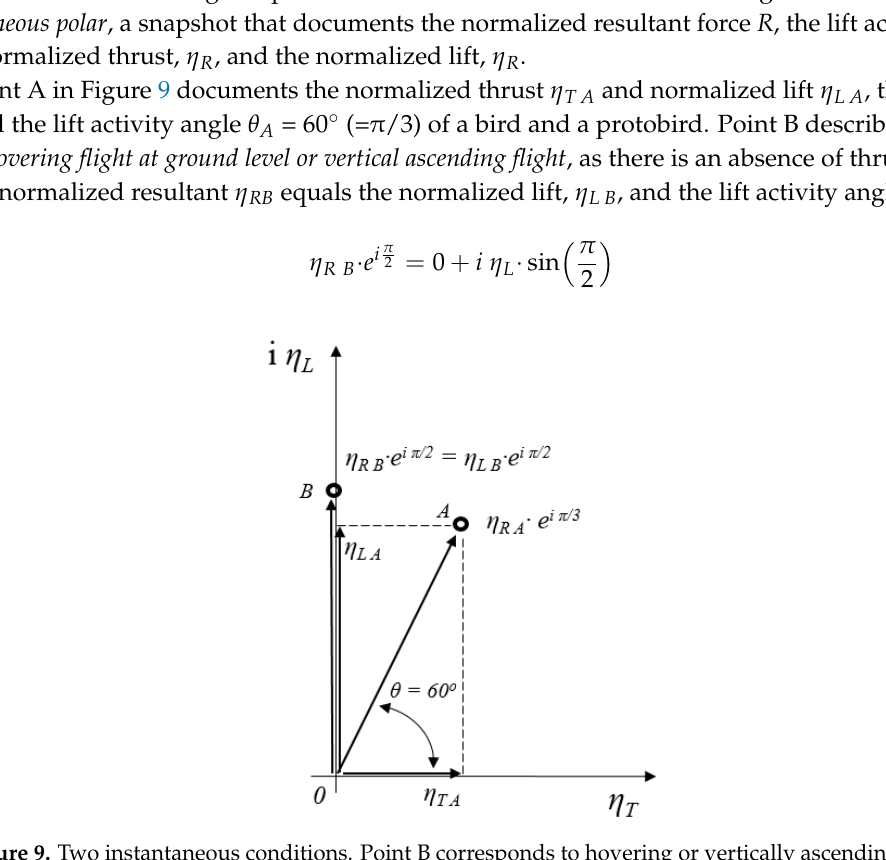
Figure 9. Two instantaneous conditions. Point B corresponds to hovering or vertically ascending